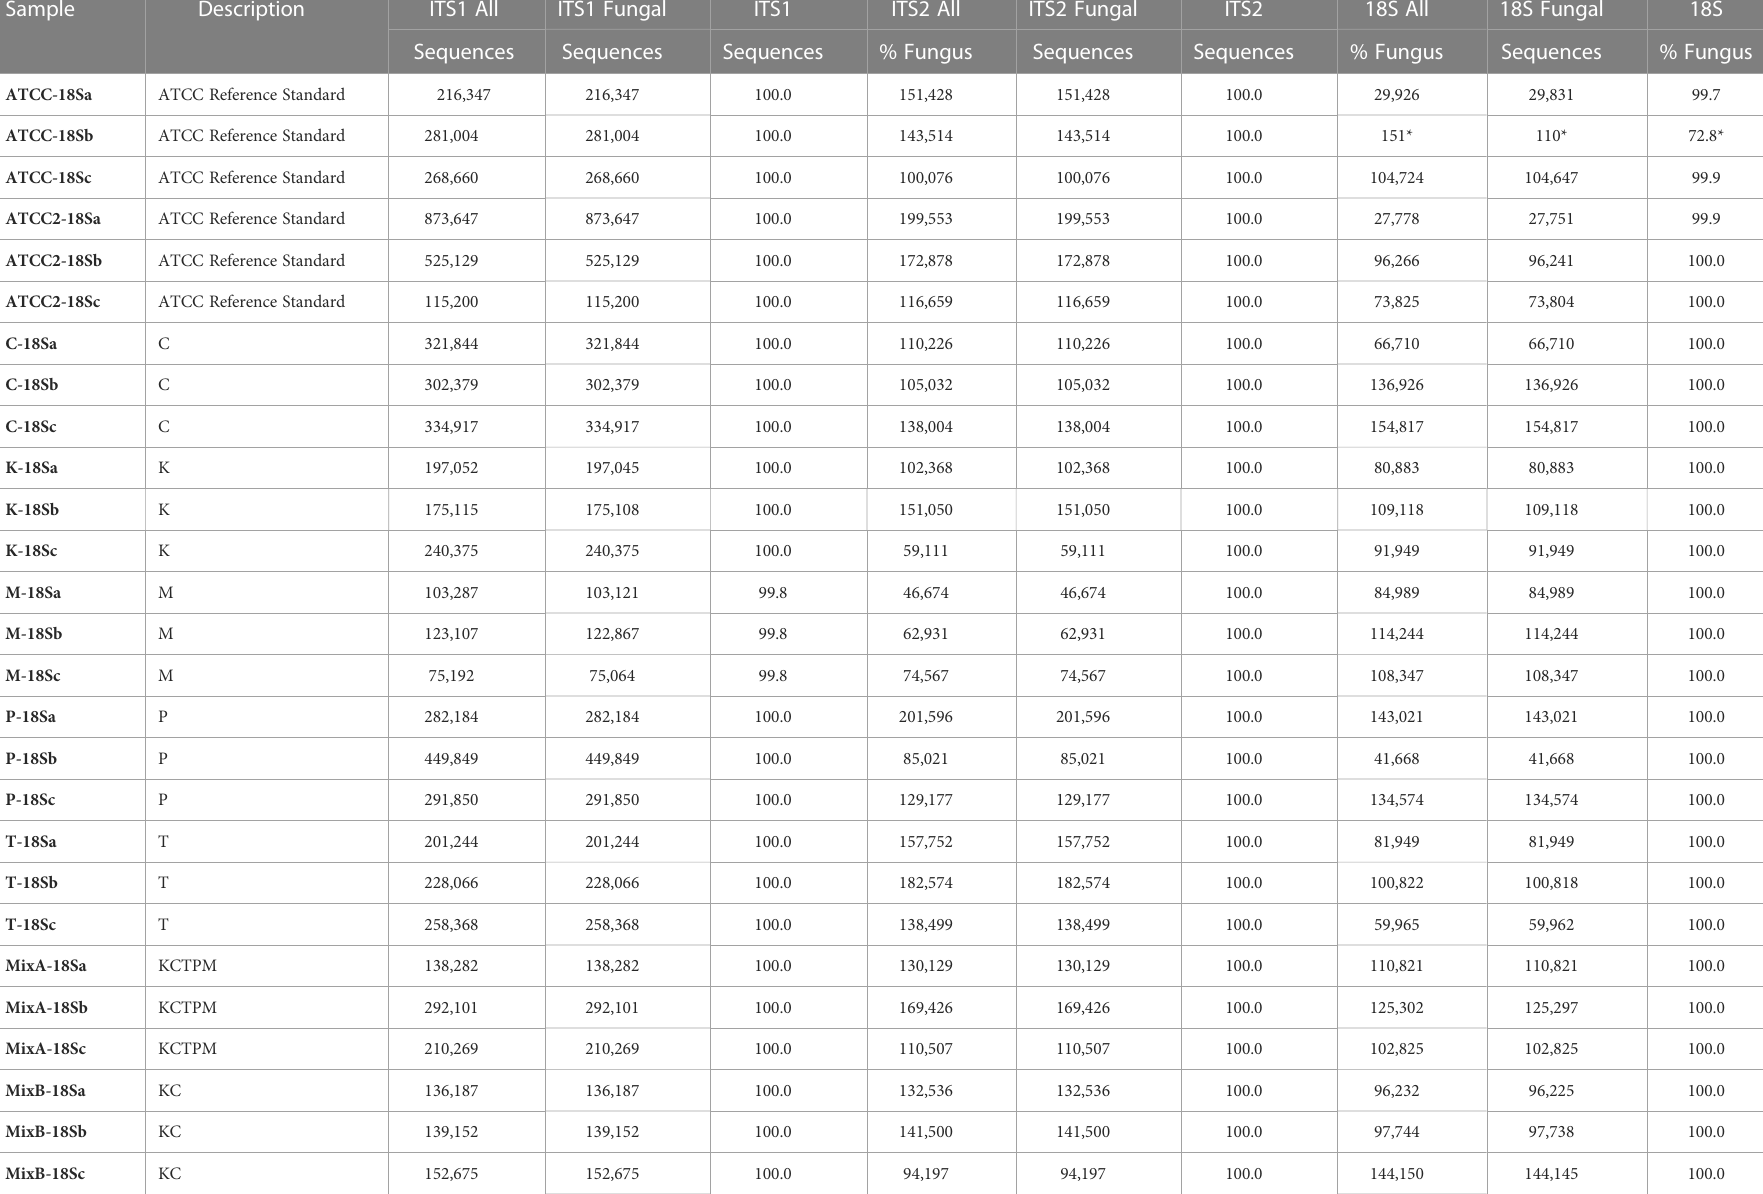
TABLE 4 Sequences identi fi ed as fungal from ITS1, ITS2, and 18S amplicon sequencing using the UNITE ITS or Silva 18S databases.